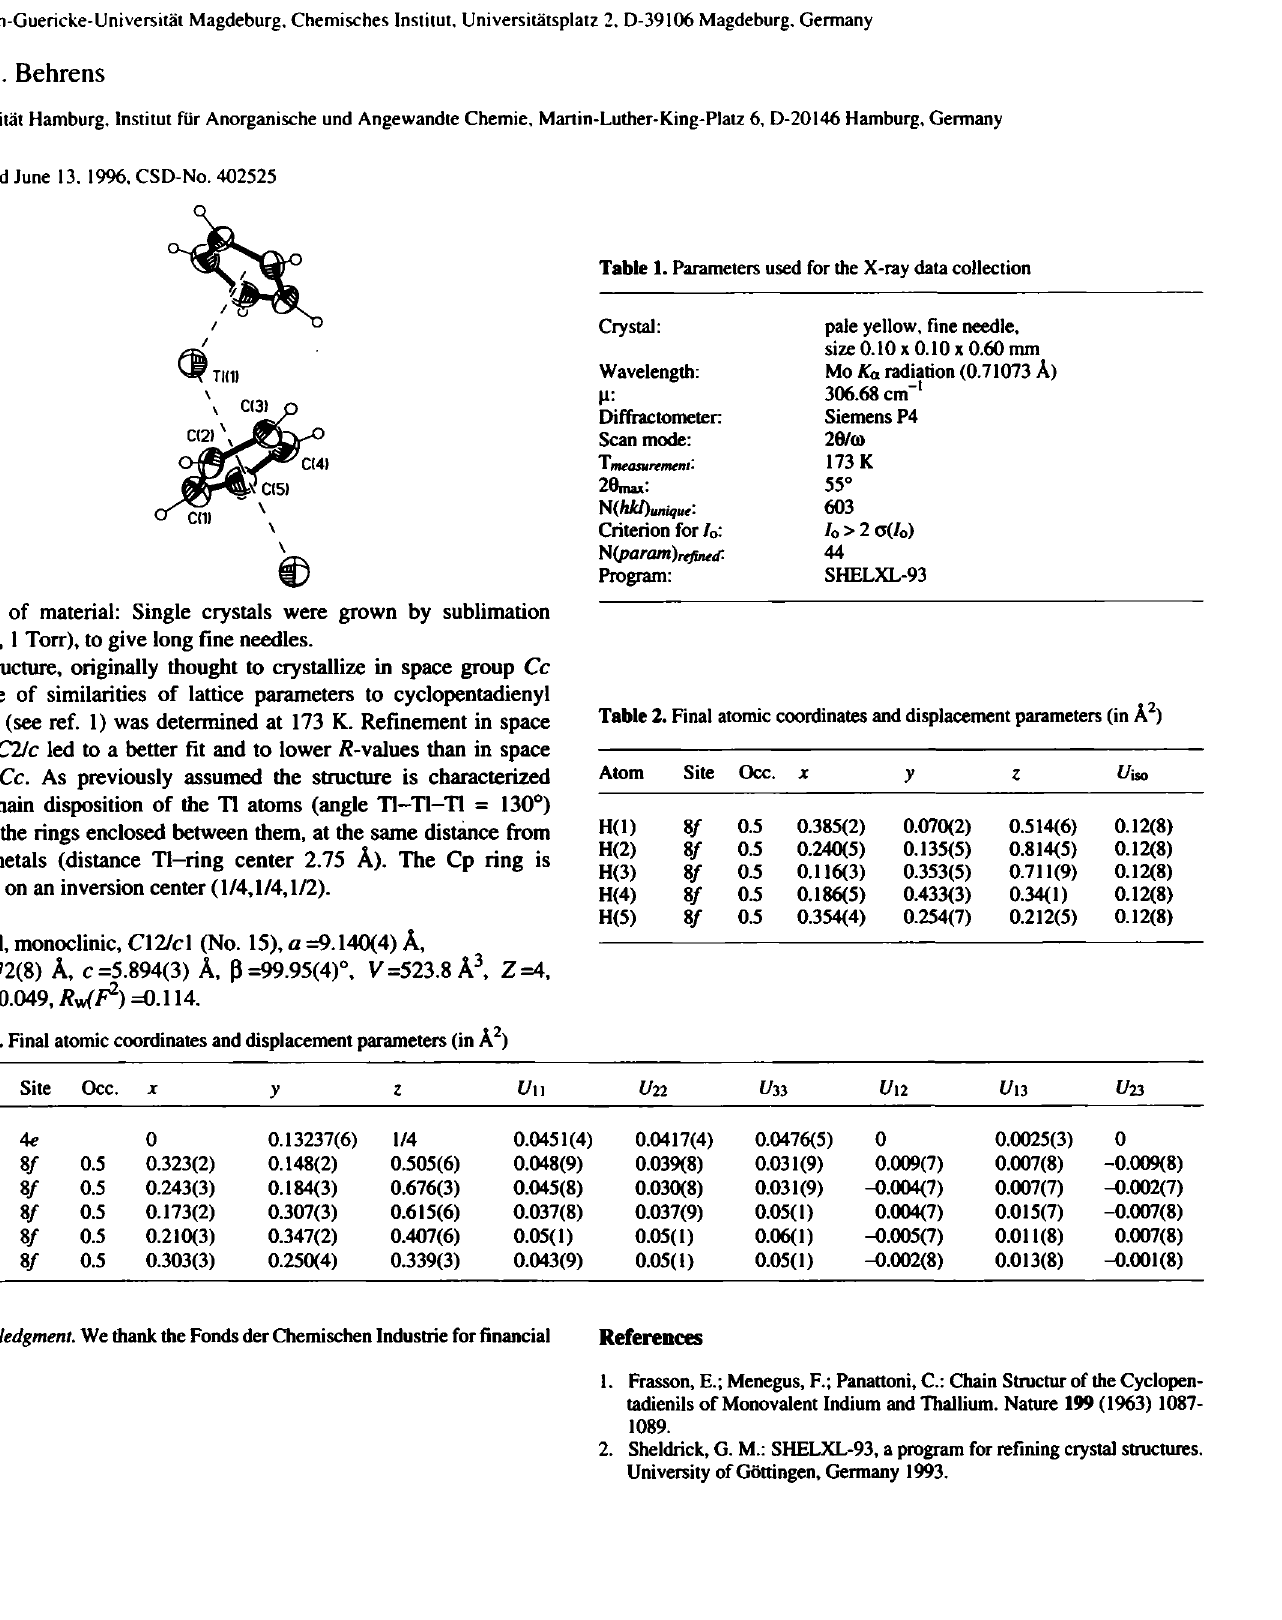
Table 1. Parameters used for the X-ray data collection